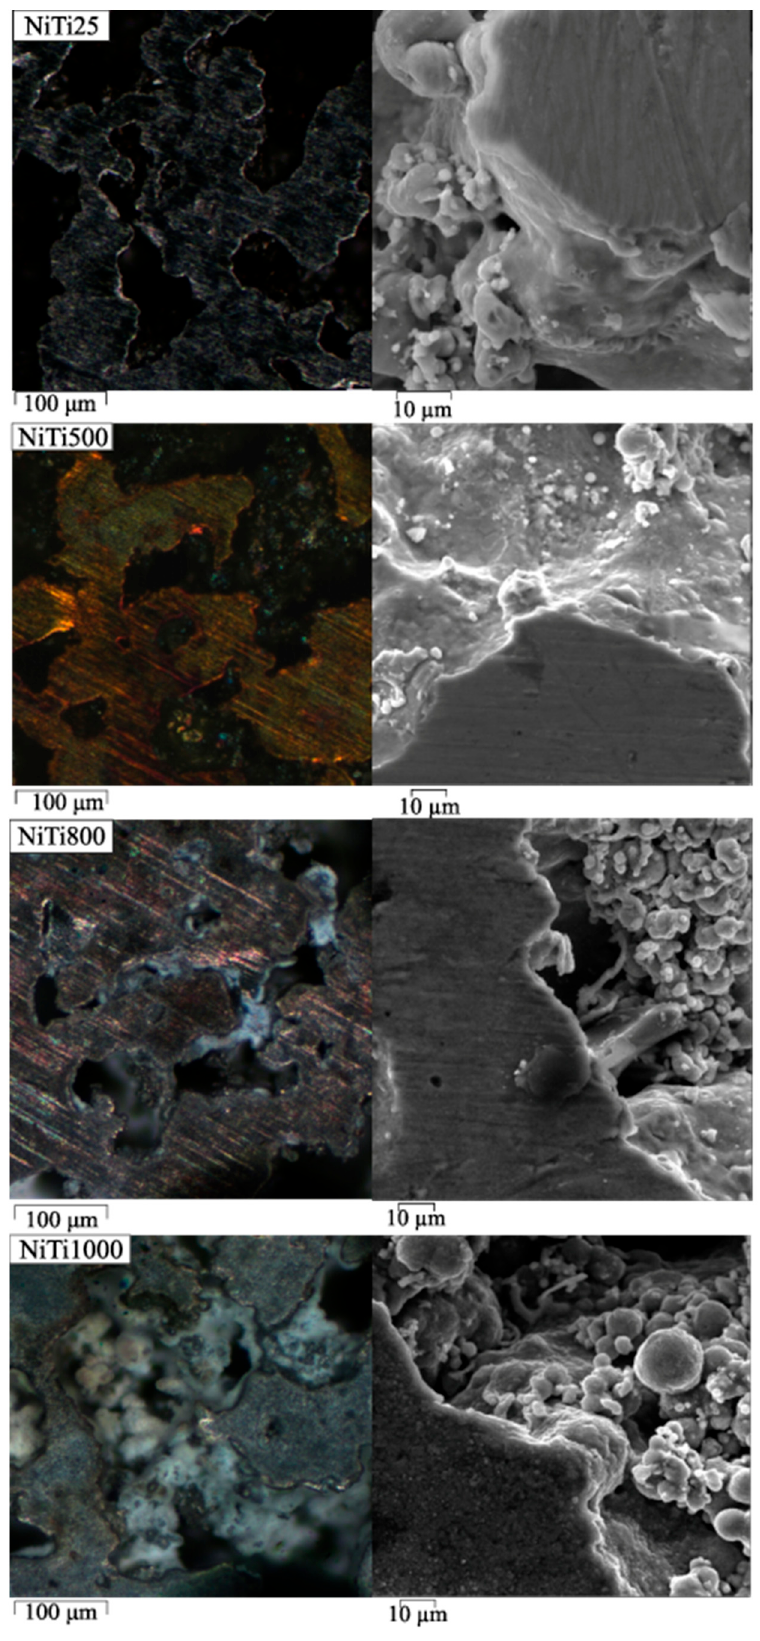
Figure 3. Optical and SEM microscopy images of surfaces of NiTi porous samples.